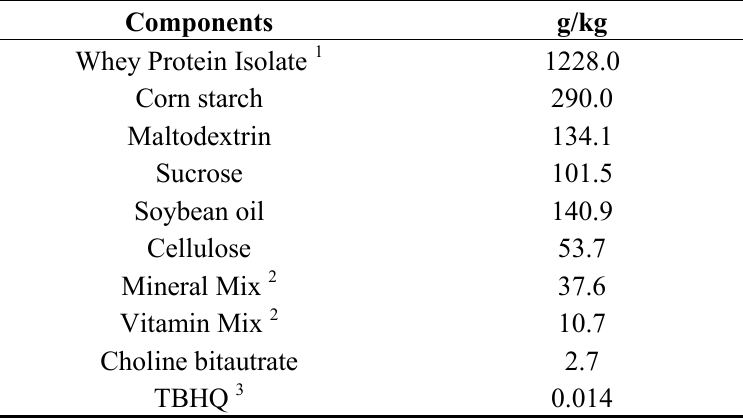
Table 1. Meal composition.